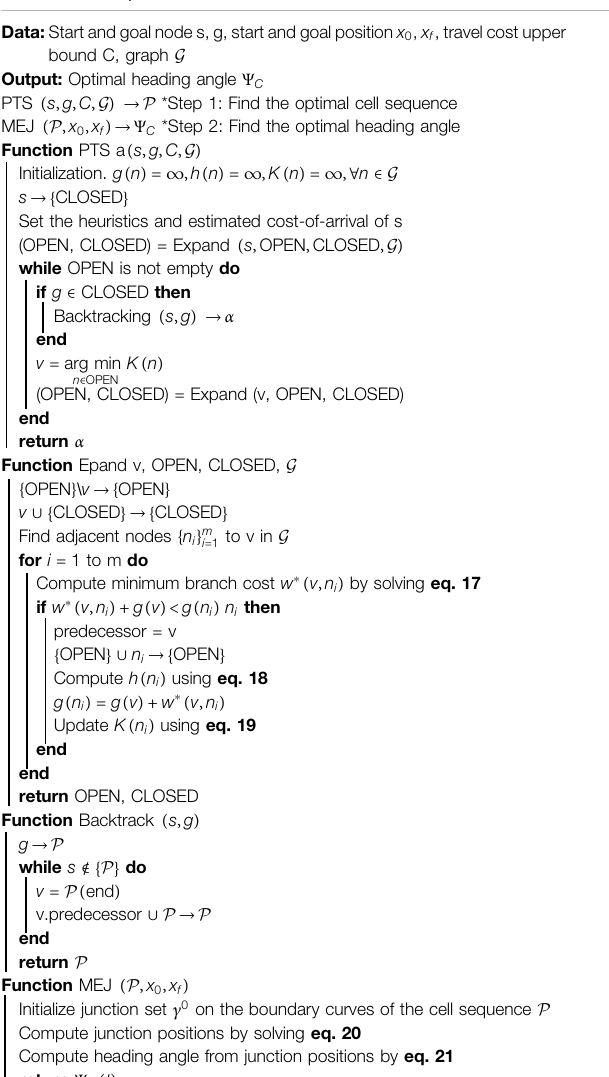
ALGORITHM 3 | Bounded Cost Search in Piece-wise Constant Flow